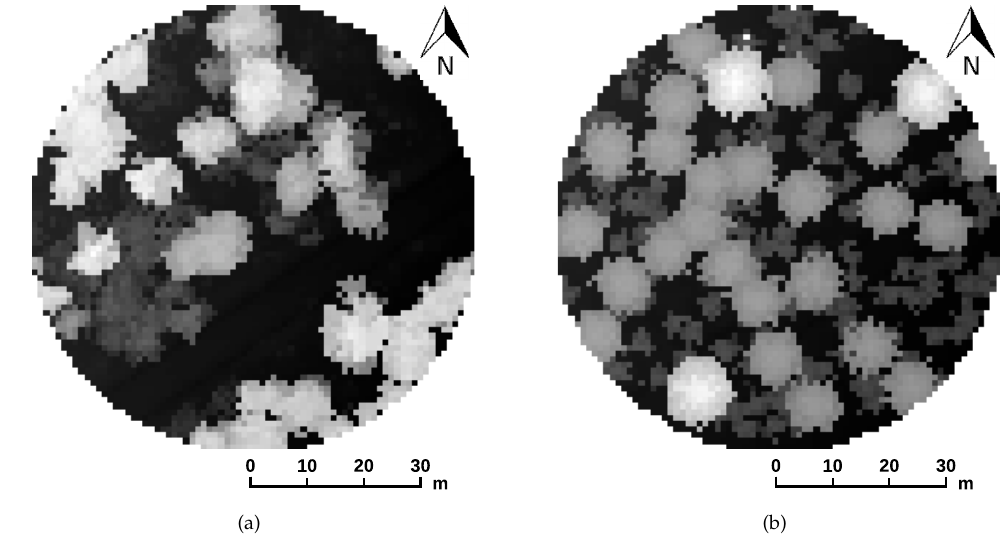
Figure 3. ( a ) Height grids of the original airborne laser scanning (ALS) point cloud and ( b ) a corresponding synthetic point cloud with 1 m resolution. The given stand is characterized by predominant oaks, some tall spruces and young beeches. The median height of the detected trees is about 24